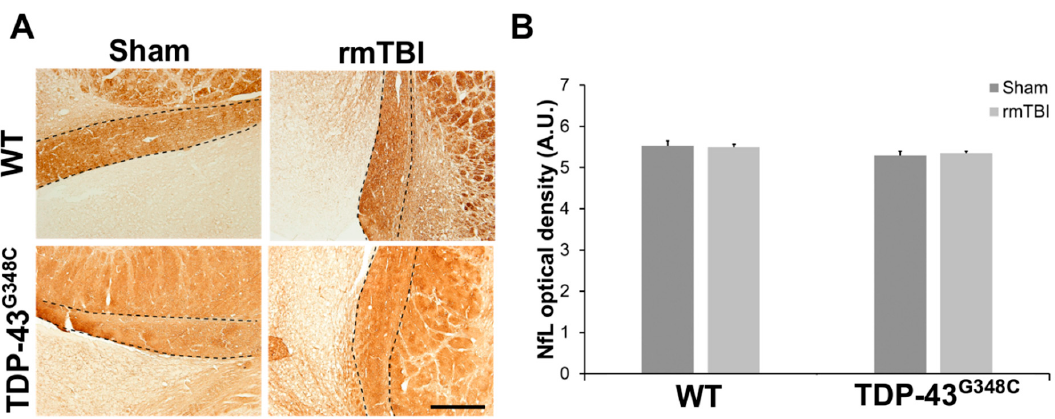
Figure 4. Neurofilament light chain (NfL) expression in the optic tract (OT) of wild ‐ type (WT) and TDP ‐ 43 G348C mice at 6 months after repetitive mild traumatic brain injury (rmTBI). ( A ) Representative microphotographs of the OT stained with anti ‐ neurofilament light chain protein. Dashed lines indicate the OT. Scale bar: 200 μ m ( B ) The histogram shows NfL optical density (AU) in the axons of the OT in WT and TDP ‐ 43 G348C mice with rmTBI and related control groups (Sham). Results are expressed as means ± SEM ( N = 3–5).